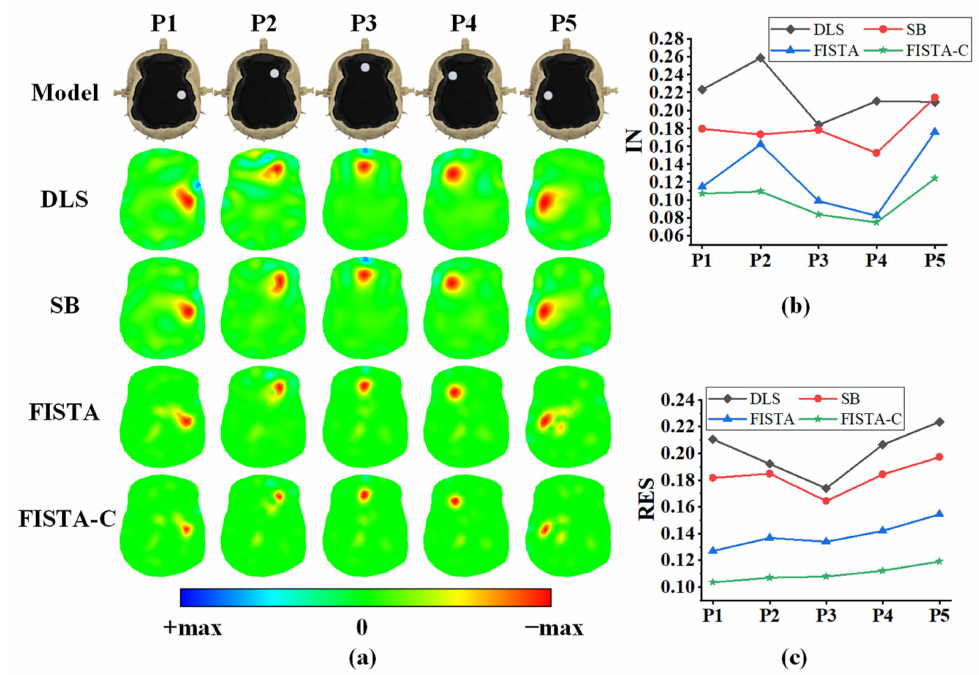
Figure 7. Reconstruction results of a single target at various locations in the head phantom model. ( a ) Phantom model and imaging results of DLS, SB, FISTA, and FISTA-C, respectively. ( b ) Image noise (IN) analysis of imaging results of the four algorithms. ( c ) Resolutions of imaging results for the four algorithms.